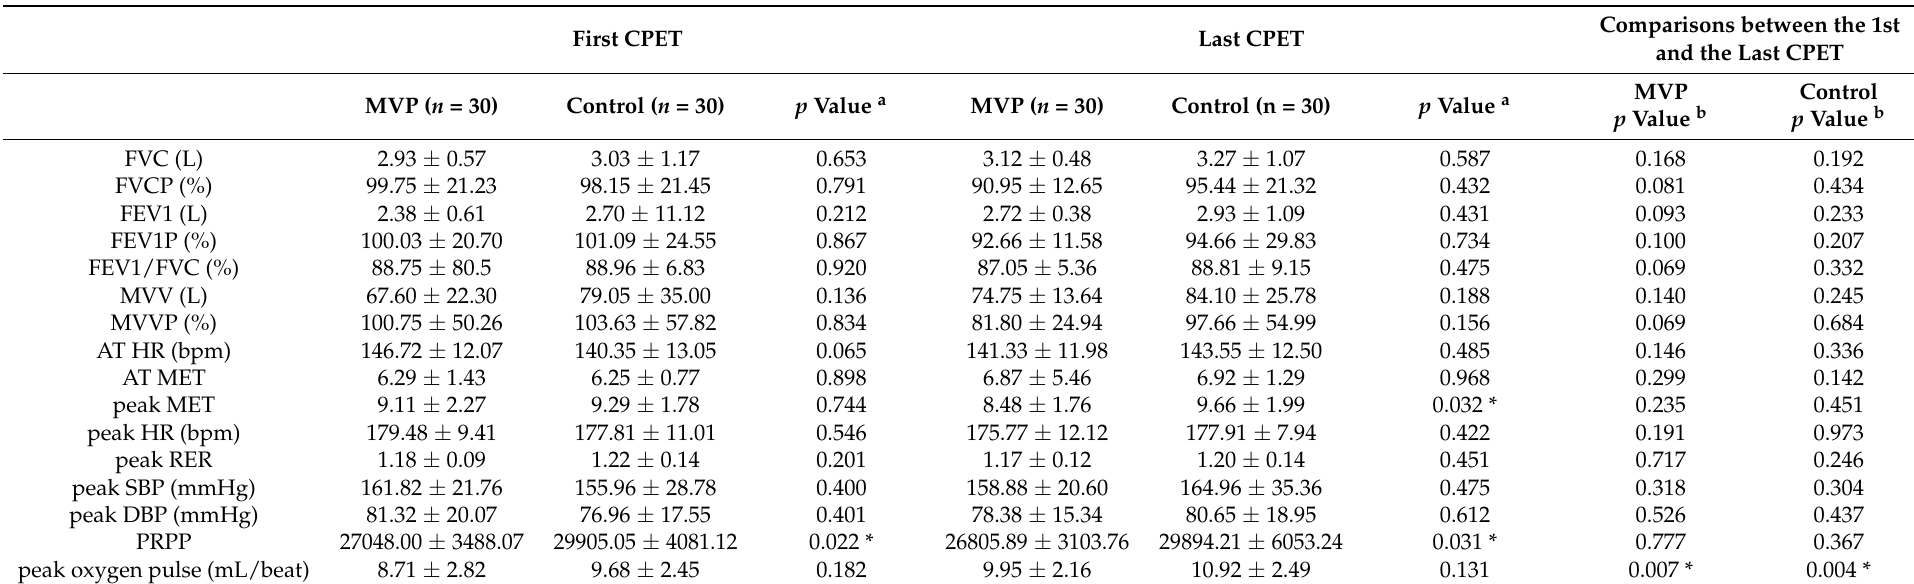
Table 2. Findings of the initial cardiopulmonary exercise testing among patients with mitral valve prolapse. First